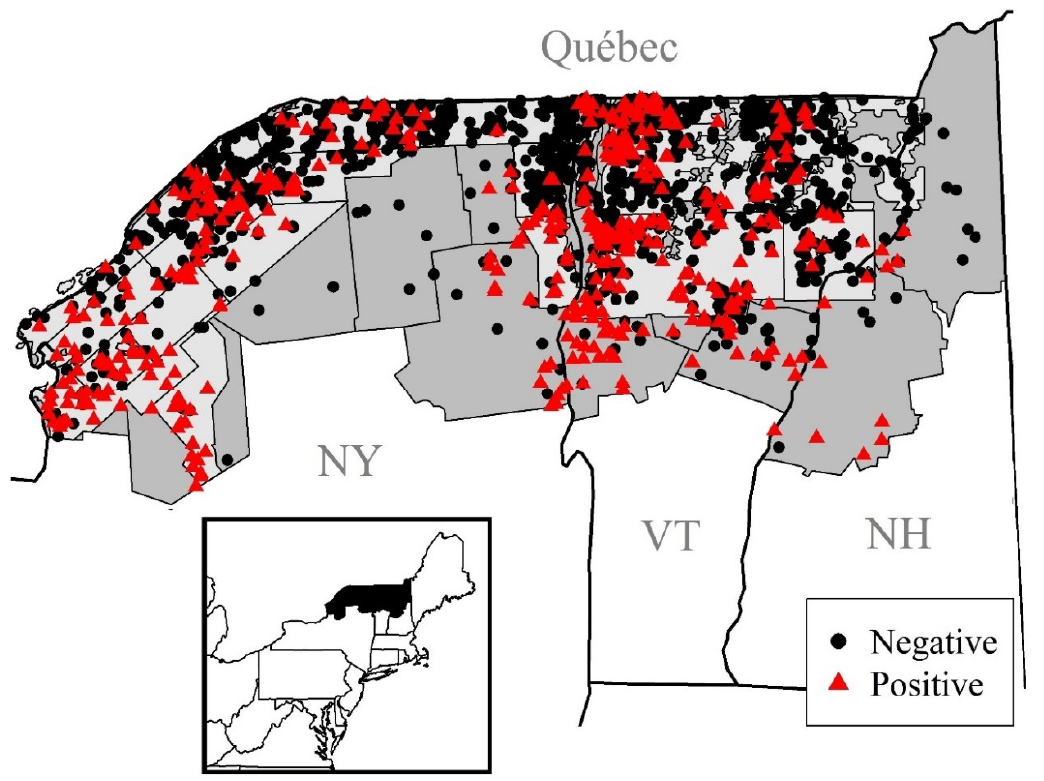
Figure 1. Map of the study area in northern New York, Vermont and New Hampshire. Locations of raccoons that were sampled from 2006 to 2017 are shown—the black circles were negative for raccoon variant of rabies virus (RABV) and the red triangles were positive for RABV. The oral rabies vaccination (ORV) zone for 2017 is shown as the light grey area.